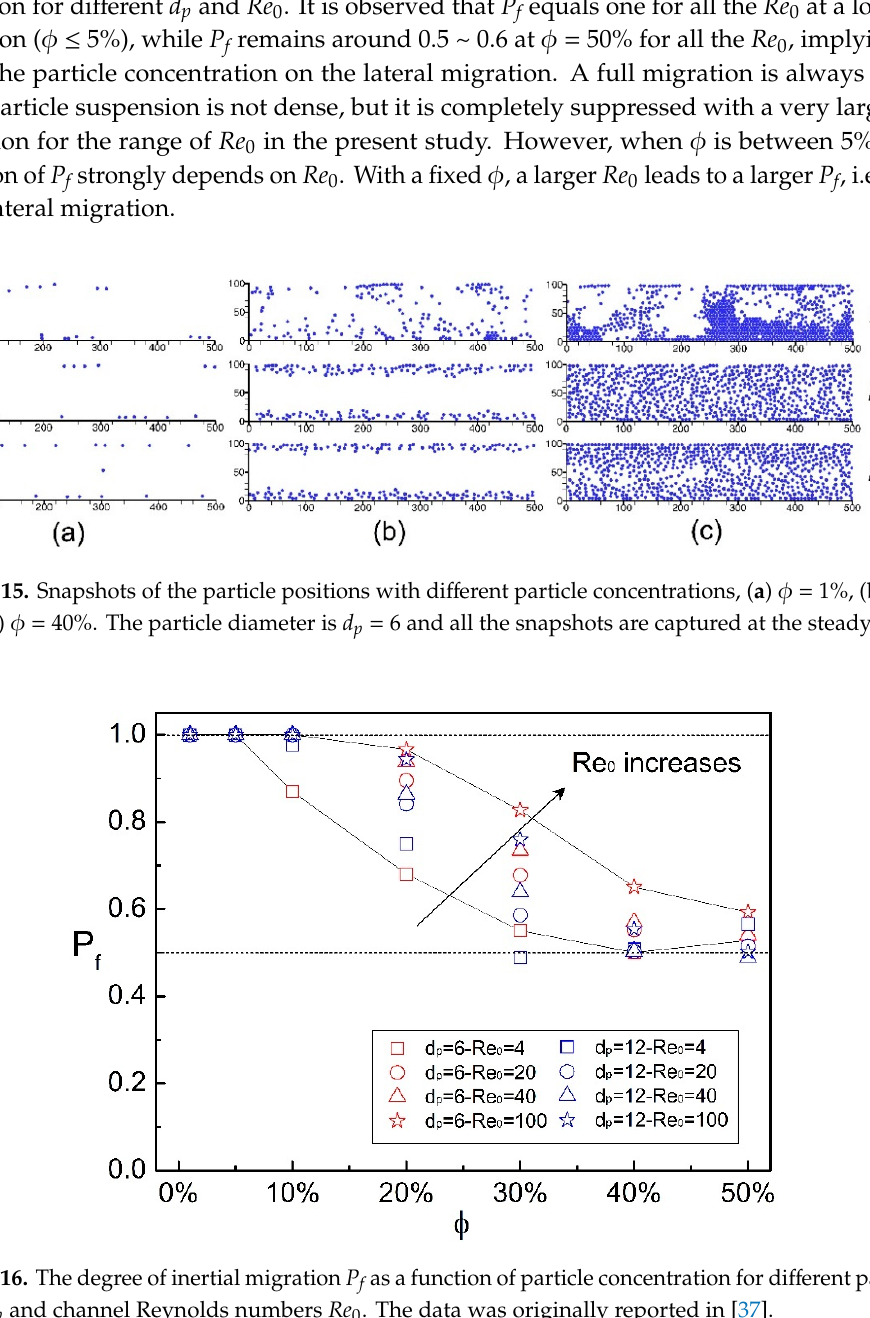
Figure 15. Snapshots of the particle positions with different particle concentrations, ( a ) ϕ = 1%, ( b ) ϕ = 10%, ( c ) ϕ = 40%. The particle diameter is d p = 6 and all the snapshots are captured at the steady state.